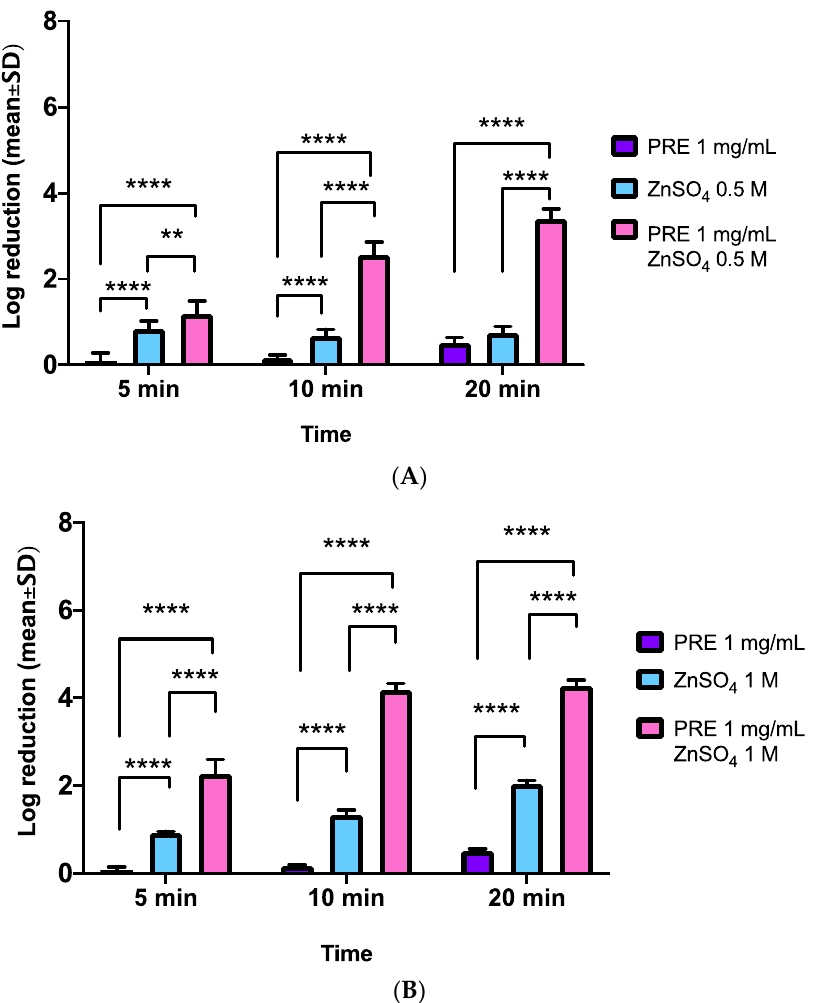
Figure 5. Log 10 reduction of P. aeruginosa CFUs at incubation times of 5 min, 10 min, and 20 min ( n = 9 ± SD). ( A ) PRE (1 mg/mL) and Zn (II) (0.5 M) alone and in combination. ( B ) PRE (1 mg/mL) and Zn (II) (1 M) alone and in combination. Tukey’s multiple comparison post-hoc test show statistically significant differences (** p ≤ 0.01, **** p ≤ 0.0001).